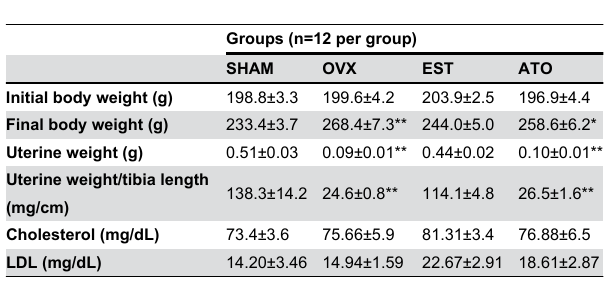
Table 1. Effect of ovariectomy and/or treatments on body weight, uterine weight and cholesterol levels.